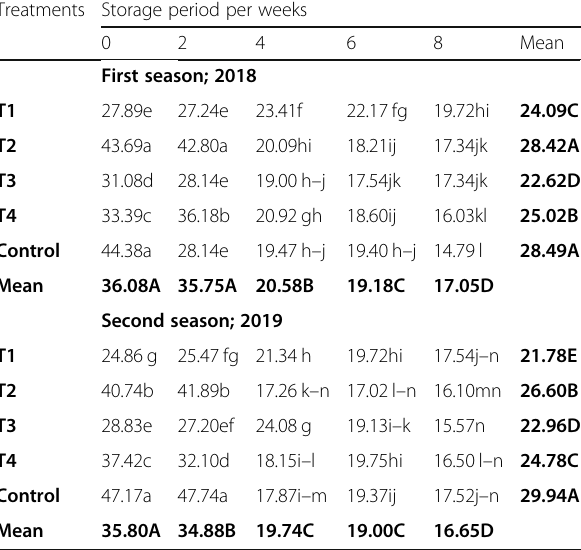
Table 4 Effect of preharvest spraying with moringa leaf extract, boric acid, and chelated calcium on hue angle of Hollywood plum fruits stored at 0 ± 1 °C and RH 85 – 90% during 2018 and 2019